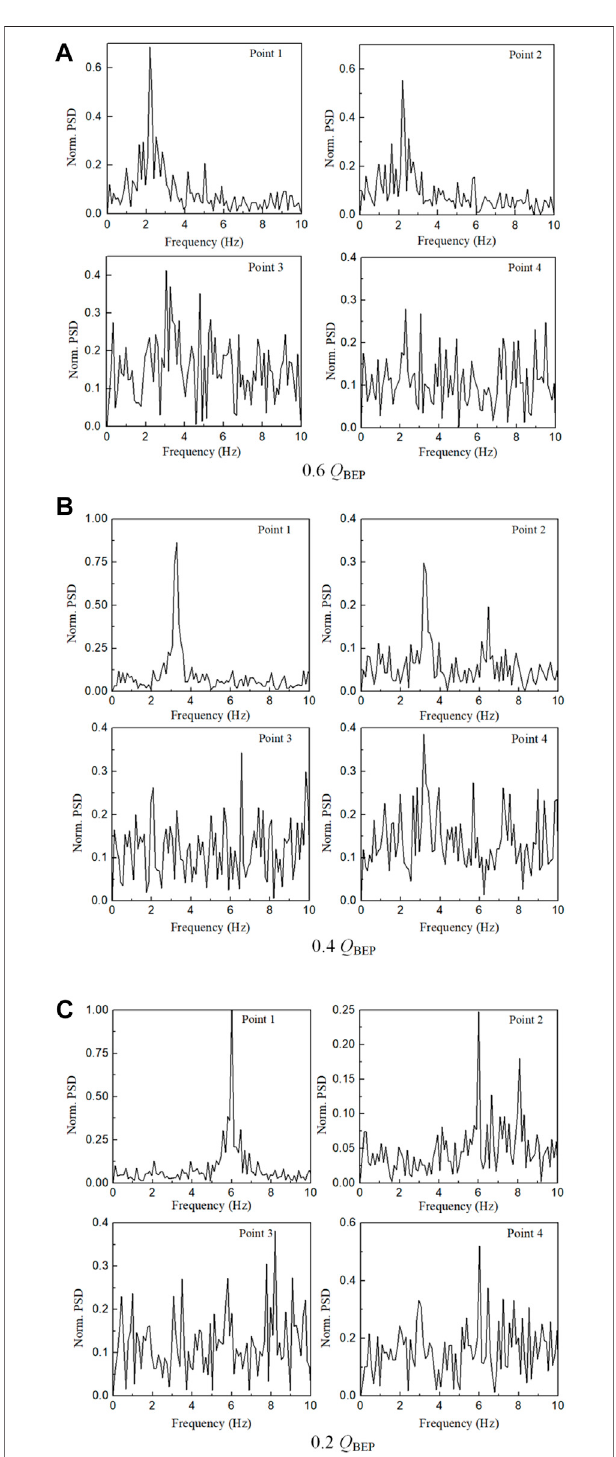
FIGURE4| Spectraofthevelocity fl uctuationsmeasuredatthreepoints, (A) 0.6 Q BEP , (B) 0.4 Q BEP , and (C) 0.2 Q BEP.